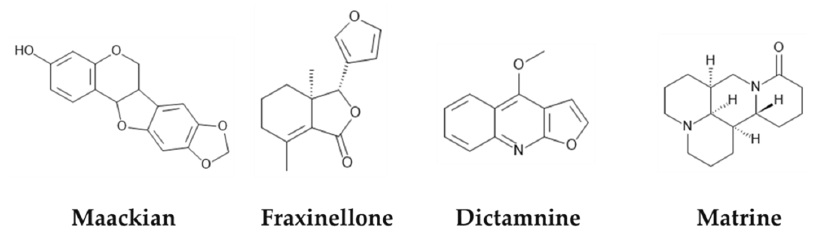
Figure 1. Chemical structure of ATB key active compounds.